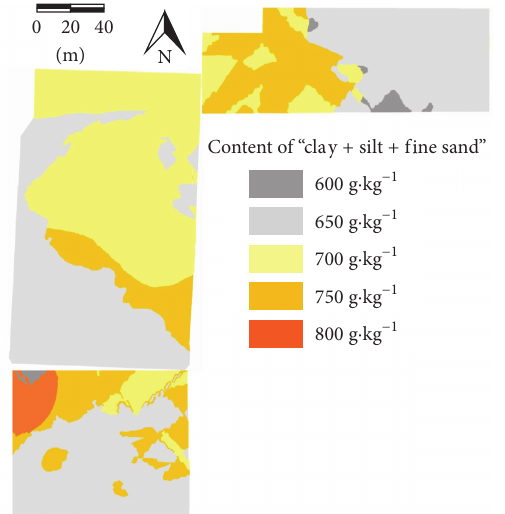
Figure 9: Management zones defined by integration of ten variables (granulometry and nutrients). 1: moderate CSS and low CN; 2: low CSS and moderate CN; 3: moderate CSS and moderate CN; 4: moderate CSS and high CN. CSS = content of clay + silt + fine sand; CN = content of